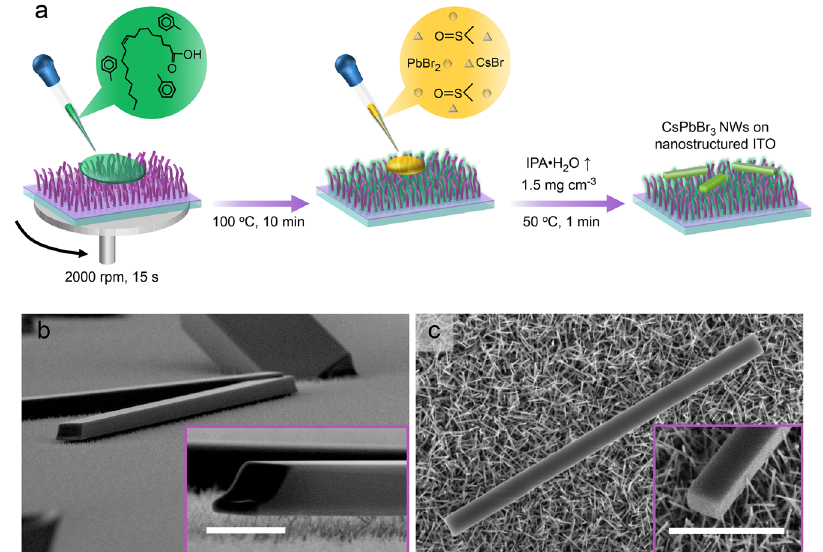
Figure 1: (a) Schematic representation of the process of perovskite NWs cultivation on nanostructured ITO substrate. (b, c) SEM images of typical CsPbBr 3 micro- and nanostructures obtained for the ITO substrate covered with oleic acid (OA) from 3(b), and5wt. % (c)toluene solution(scale bars are 1 μ m). One can see that 3 wt. % solution gives microwires having more or lessregularshapehowevertheirendfacets are distorted. Increase in OA content up to 5 wt. % results in reducing the substrate wettability and evolution of the end facets shape from distorted to